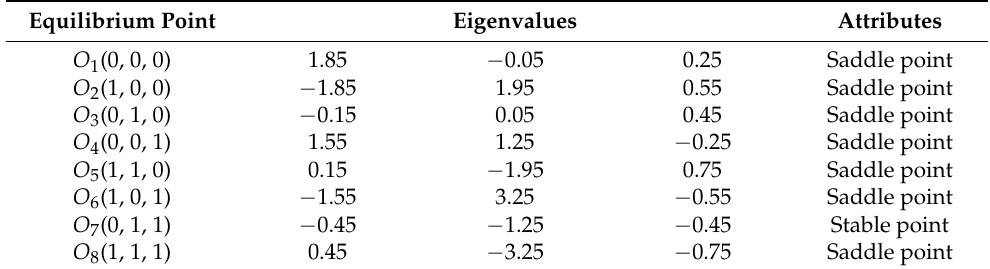
Table 4. Attribute analysis of evolutionary equilibrium points.